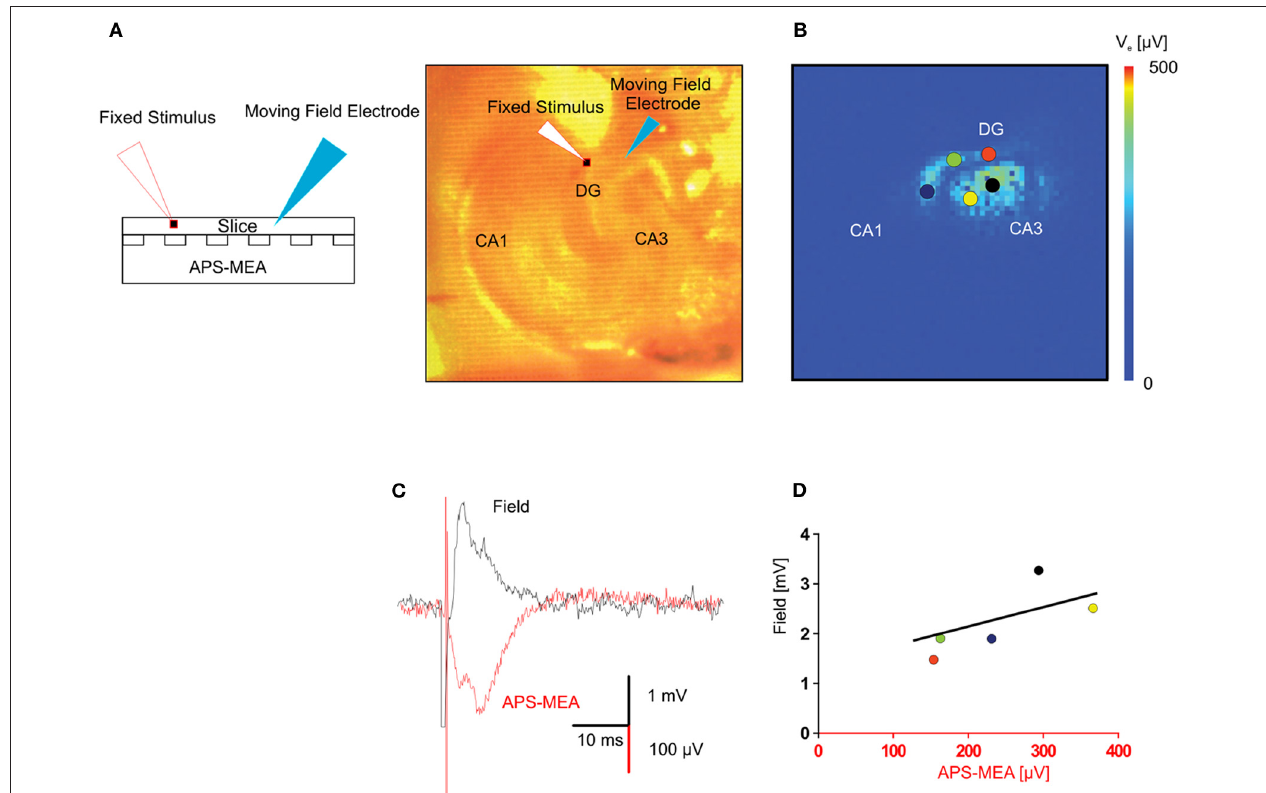
FIGURE 3 | Validation of the LFP recorded by means of high-density micro-electrode arrays through standard single field electrode recordings. (A) The picture represents the adopted experimental configuration. The hippocampal slice is placed on the electrode array and two electrodes, one for extracellular stimulation the other for extracellular recording are micropositioned on the top of the slice. (B) Color-coded map of the maximal activation with superimposed circles showing the positions of the extracellular recording electrode. (C) In the same (x, y) position, the fEPSP recorded with one electrode